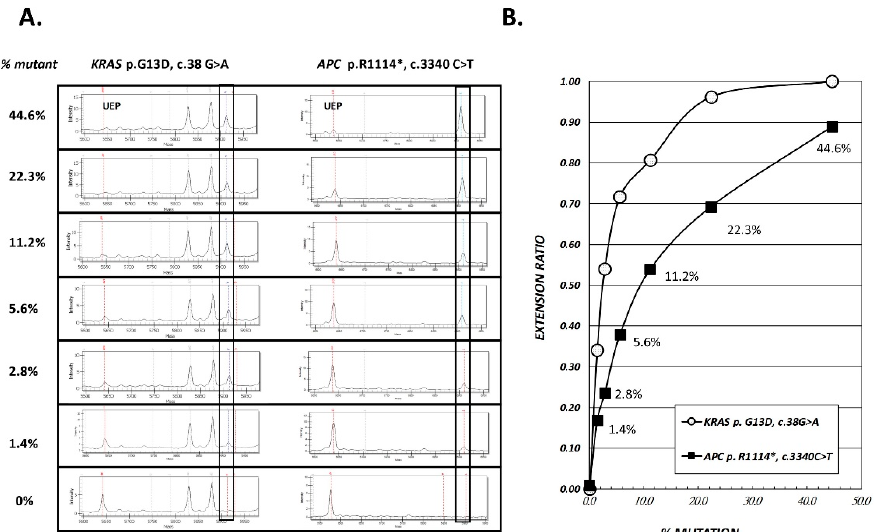
Figure 2. Accuracy and analytical sensitivity check of sDNA panel using the LoVo cell line. Two mutations, KRAS p.G13D and APC p.R1114*, are known to be harbored in the LoVo cell line and could be detected by the sDNA panel. ( A ) Mass spectrometric (MS) analysis of two mutations, with their mutant percentages shown. The marked rectangular boxes indicate the expected size of each mutant extension product. ( B ) Regression curves of the calculated extension ratio (ER) and mutation % values for the two mutants.